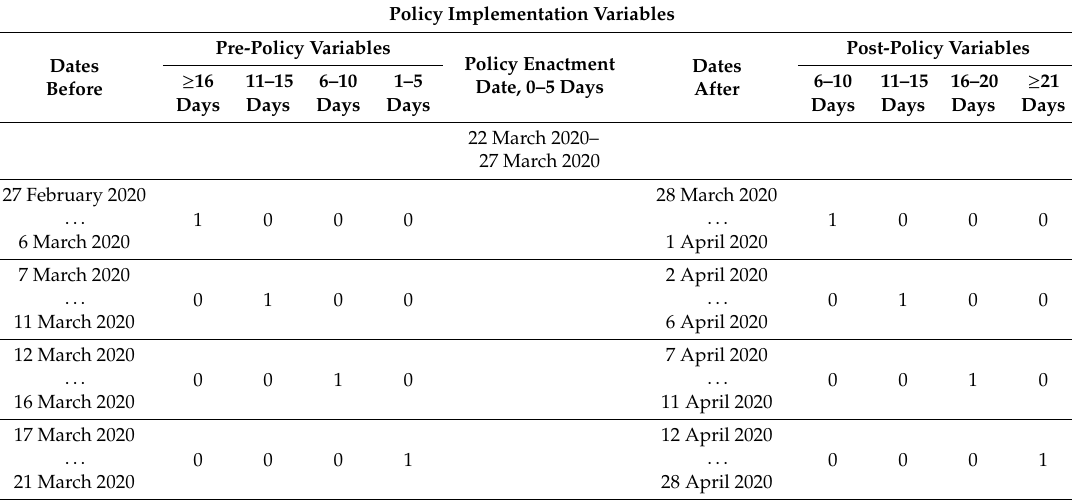
Table 2. Data structure: an example of New York State in the COVID-19 shutdown model. Policy Implementation